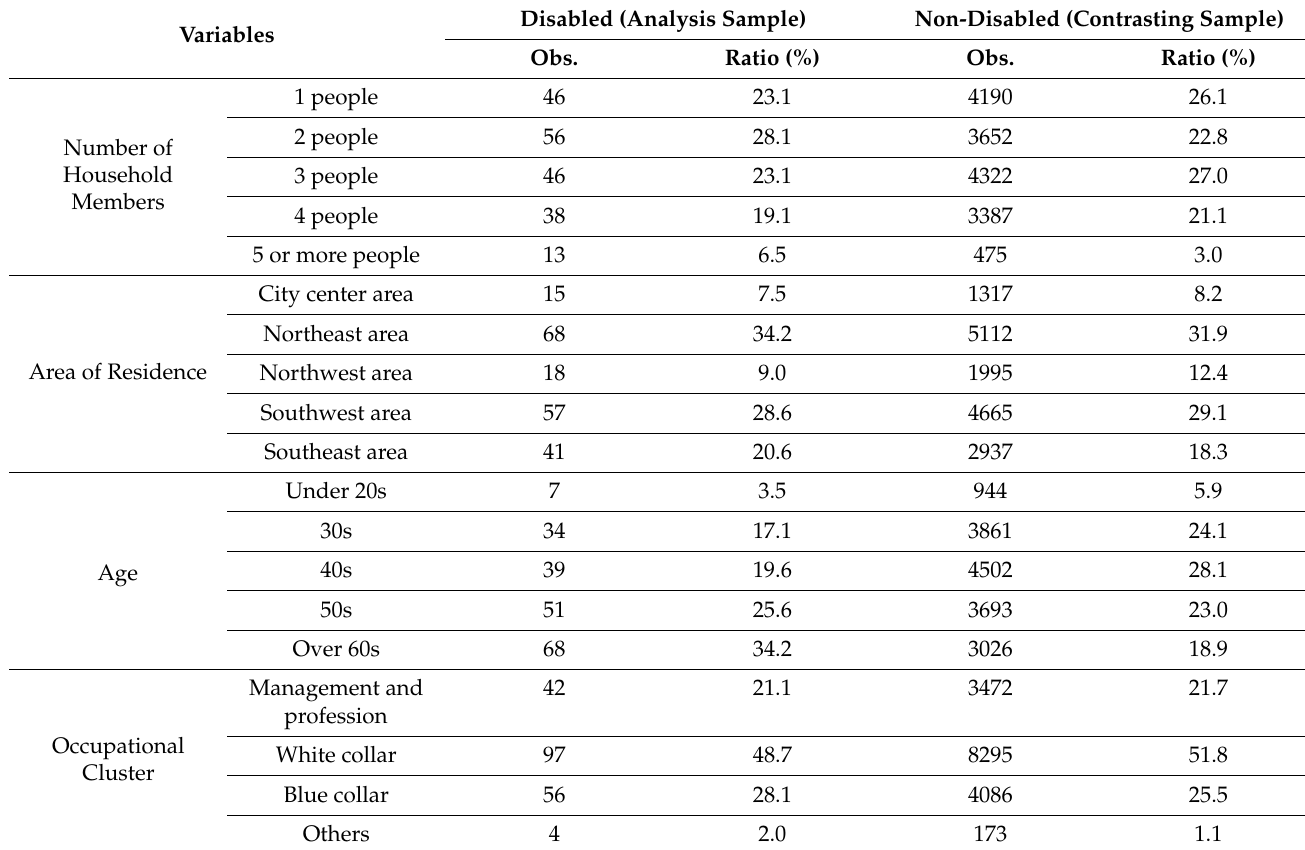
Table 2. Sociodemographic Characteristics by Disabled and